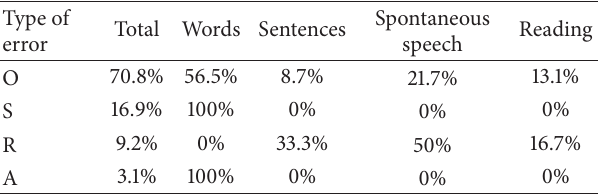
Table 3: Types of verbal apraxic